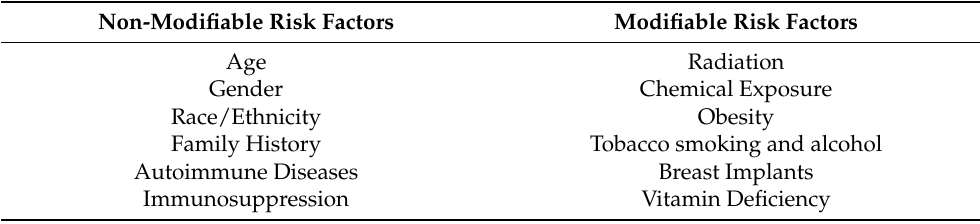
Table 1 indicates modifiable and non-modifiable risk factors. Table 1. Modifiable and non-modifiable risk